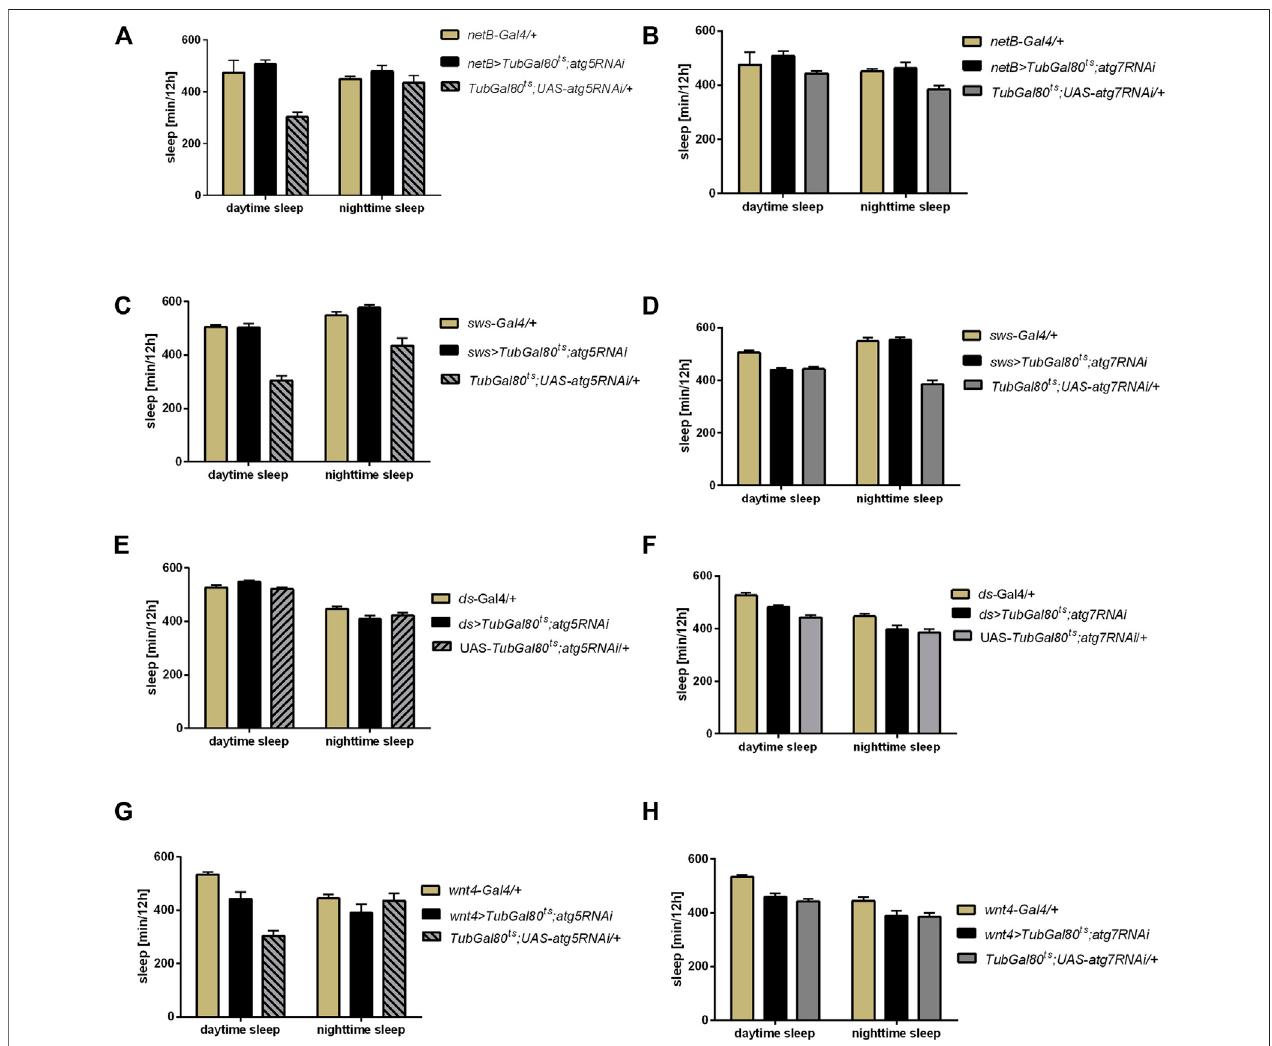
FIGURE 3 | Effect of autophagy disruption in speci fi c glia types on sleep level. Expression of atg5RNAi and atg7RNAi in epithelial glia ( netB marker) (A,B) , ensheathing glia ( sws driver) (C,D) , marginal glia ( ds driver) (E,F) and optic chiasm glia ( wnt marker) (G,H) did not affect sleep time.